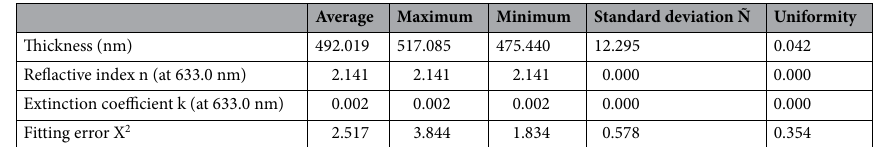
Table 1. Results of thickness measurements and the value of the refractive index n parameter for the deposited SiN layer.